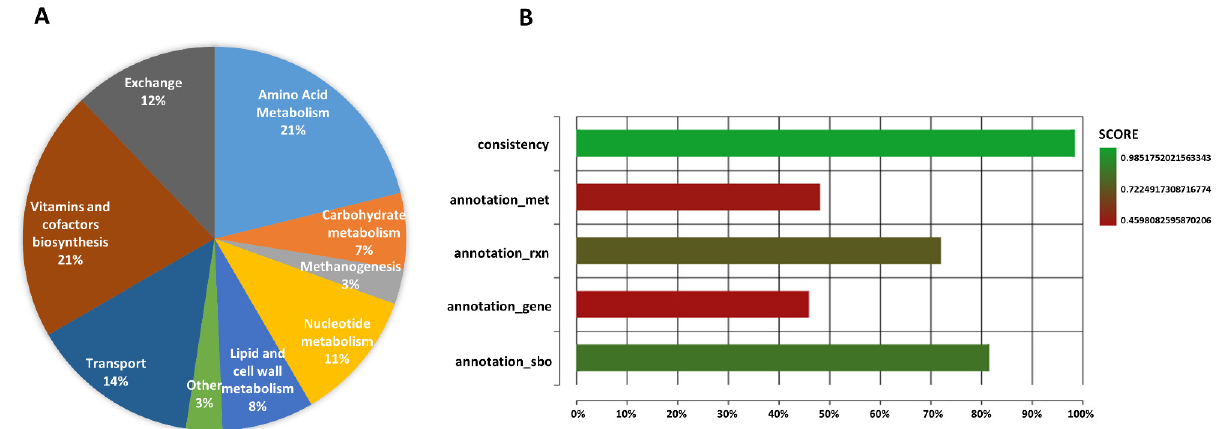
Figure 1. ( A ) The distribution of reactions in i MN22HE sorted by metabolic subsystems. ( B ) MEMOTE score of iMN22HE regarding the quality of model consistency, metabolites, reaction, gene and sbo term annotation degree. The quality of the GEM reconstruction is the total evaluated with 83%.